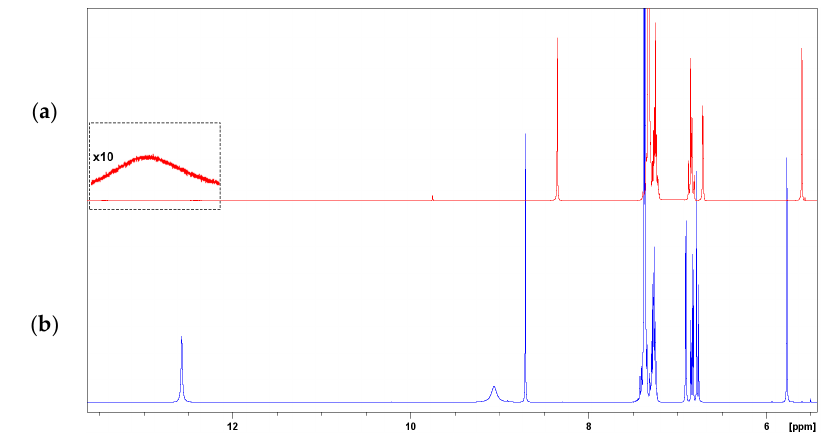
Figure D3. 1 H-NMR spectra of pOHsaladpm in ( a ) CDCl 3 and ( b ) DMSO-d 6 .